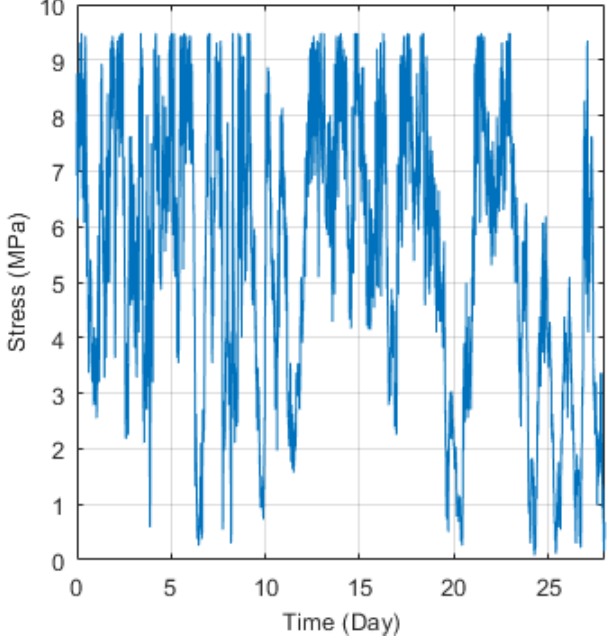
Figure 4. Estimated stress history for a period of 4 weeks for a single 5 MW wind turbine.